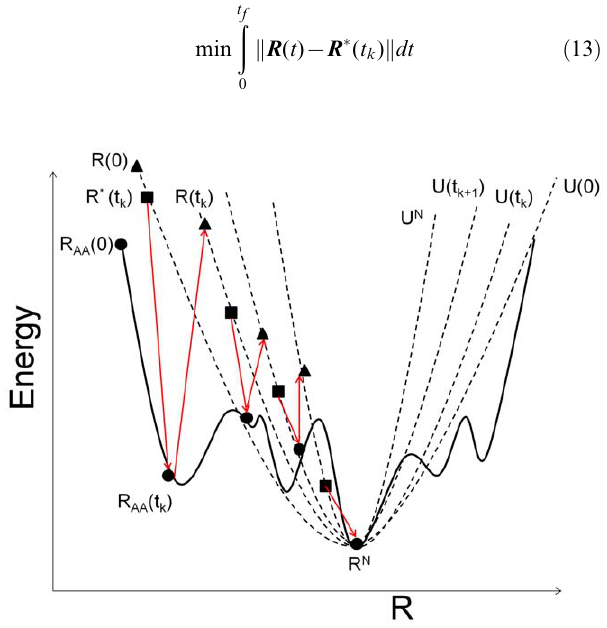
Figure 3. Exchange between the updated CG potentials and the true all-atom MD potential. Dashed parabolas are the CG potentials that are updated. Arrows show the hopping between potentials at different sampling times t k , t k z 1 , etc. until the native state is reached. Triangle represents the initial state in each CG optimization. Square represents the optimal target C a conformation. Circle represents the all-atom structure reached after MD refinement. Triangle-square- circle sequence is one computational cycle of CG optimization and MD refinement.